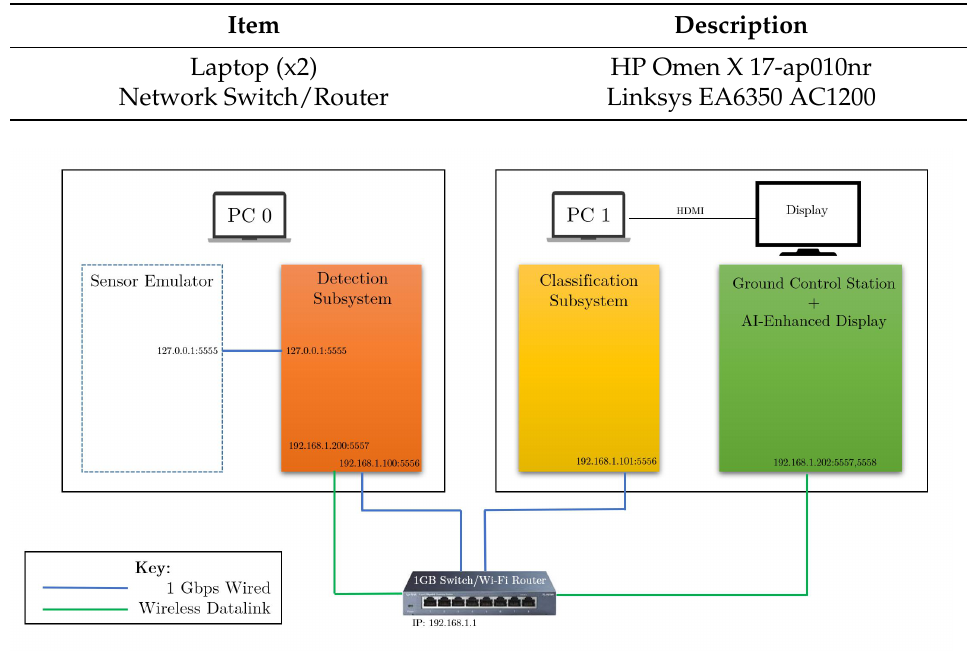
Table 1. Description of commercial hardware.